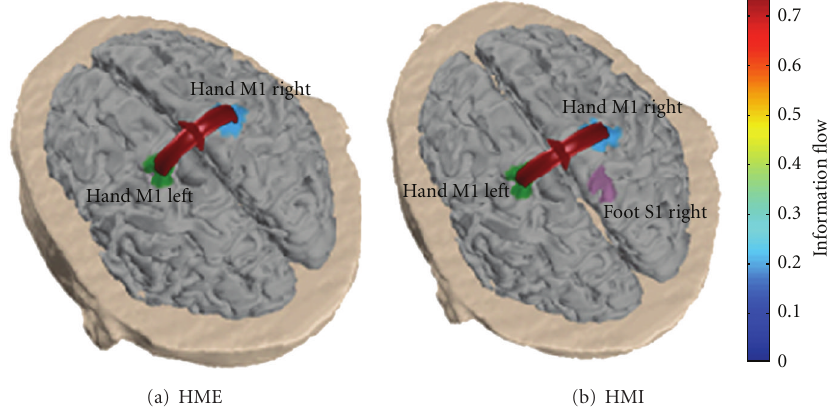
Figure 6: Identical high Information outflow from the cortical ROI corresponding to hand area of motor cortex contralateral to movement towards the same ipsilateral area during (a) Hand Motor Execution (HME) and (b) Hand Motor Imagery (HMI).